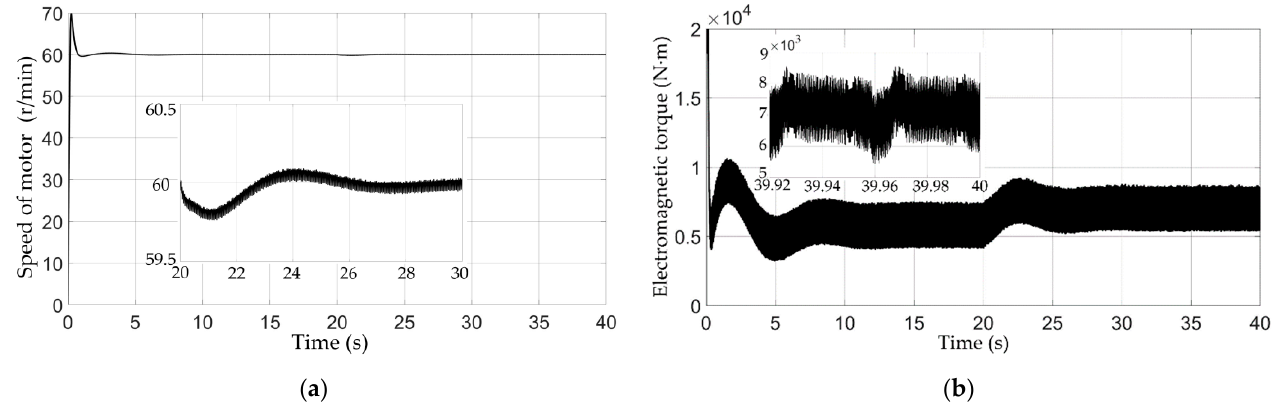
Figure 15. Response curve of driving motor of traditional belt conveyor system under variable load operation conditions. ( a ) Speed curve; ( b ) Electromagnetic torque curve.